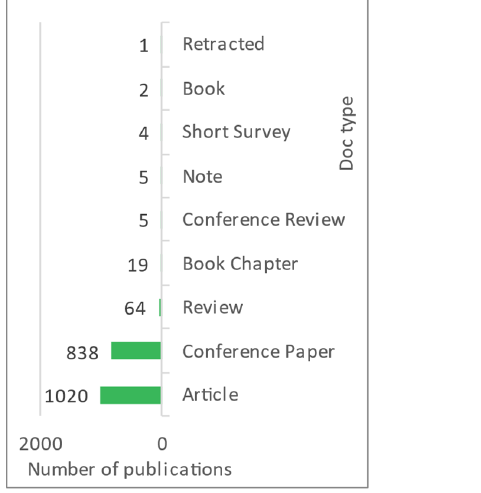
( b ) Figure 5. Trends in the number of publications in the area of study ( a ) worldwide ( b ) per country.